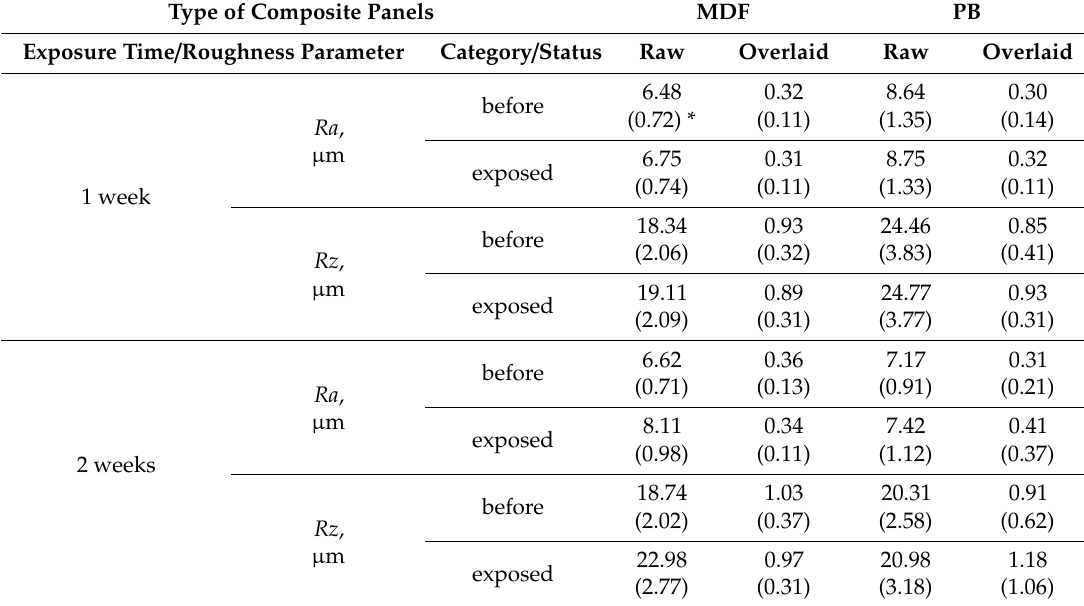
Table 2. Average values of surface roughness of the composite samples before and after exposure to humidity conditions.